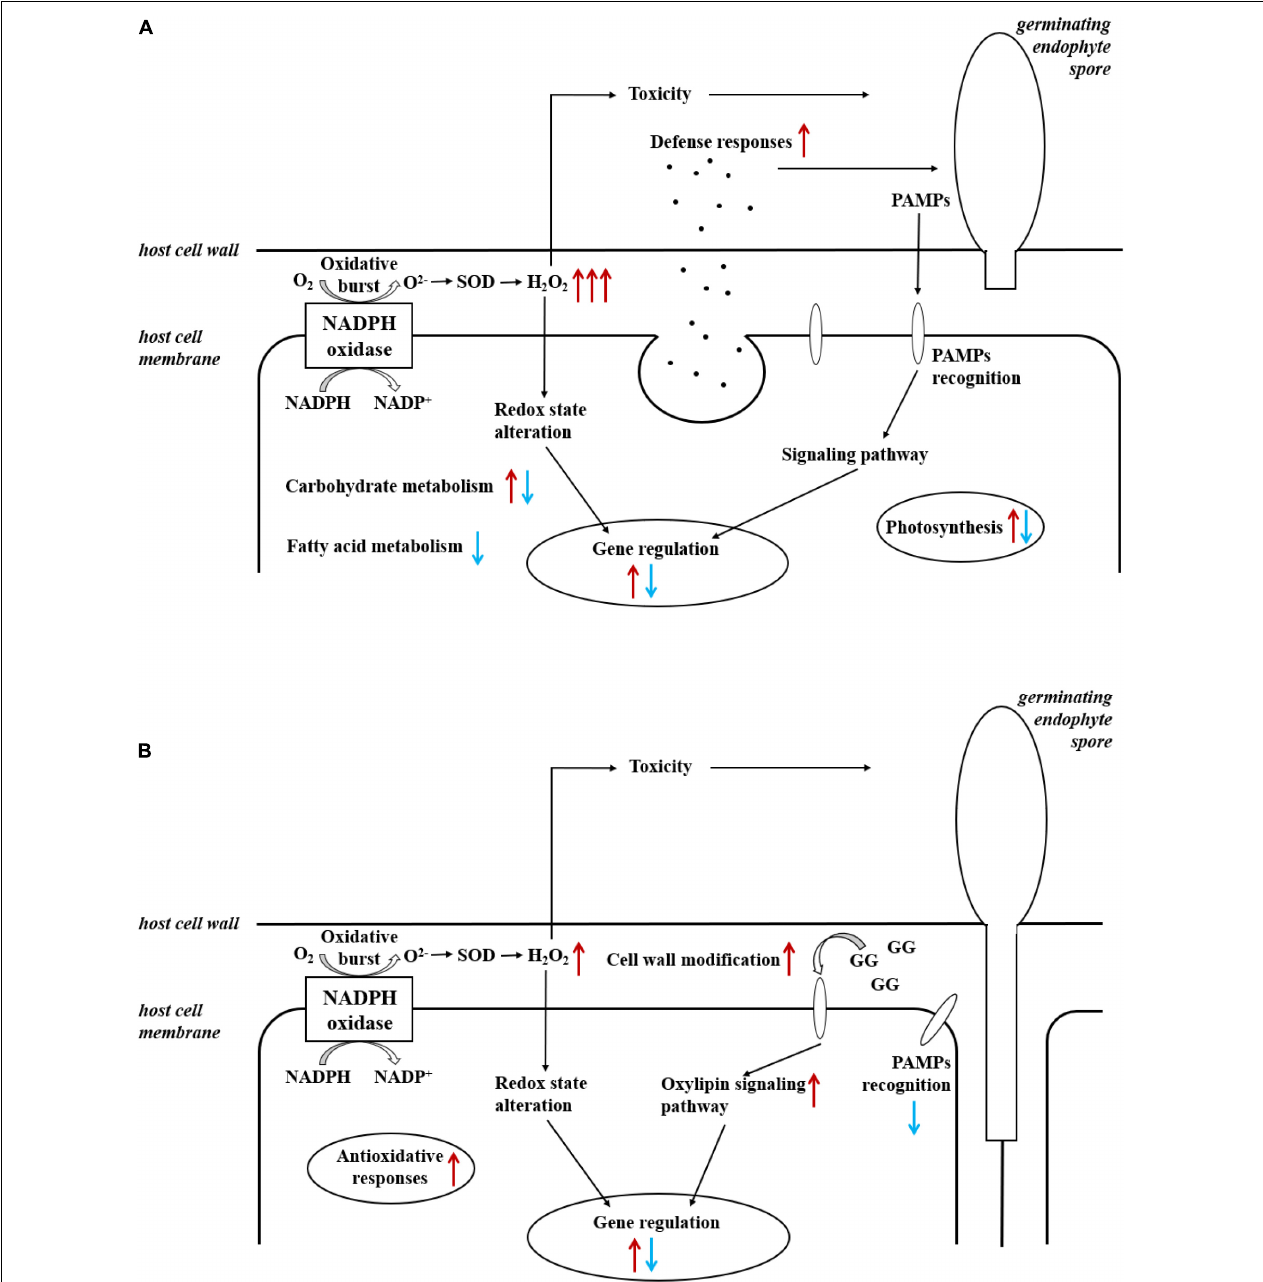
FIGURE 4 | Summary of induced responses in (A) L. digitata and (B) S. latissima during the interactions with L. elsbetiae . Red and blue arrows indicated, respectively, up- and downregulation of differentially expressed genes, in relationships with main cellular metabolisms (see also Tables 2 , 3